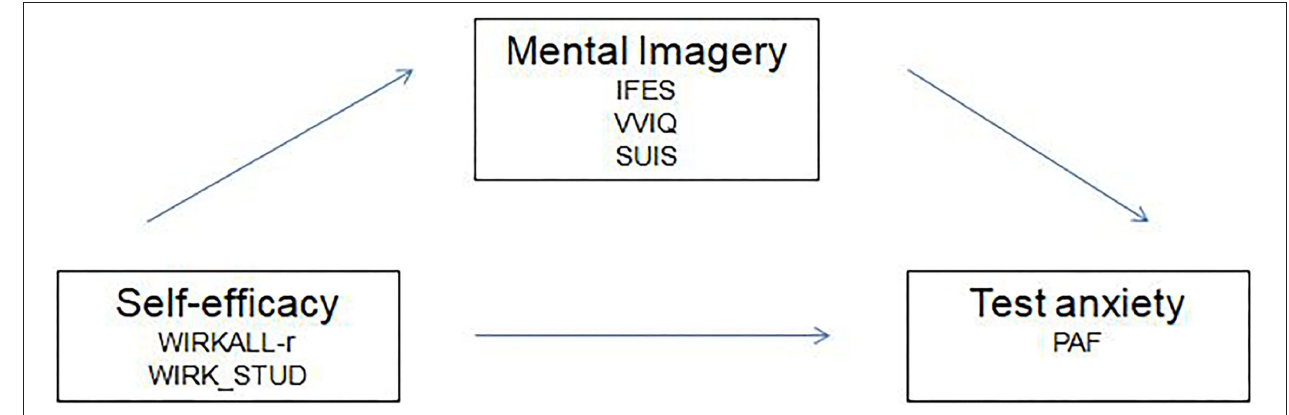
FIGURE 1 | Mediation model.